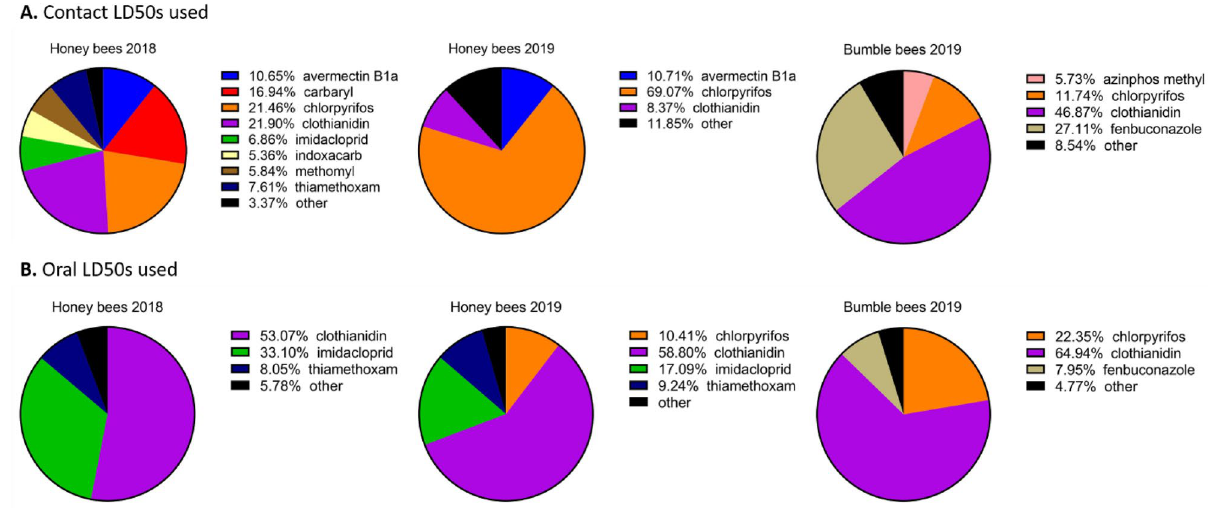
Figure 2. Contribution of individual active ingredients to the pollen risk quotient calculations for each bee species and year (2018/2019). This was determined both for RQs calculated with contact LD 50 values ( A ) and oral LD 50 values ( B ). Toxicity data for Apis mellifera and Bombus terrestris were used depending on the pollen source. Graph created in GraphPad Prism 9 48 .